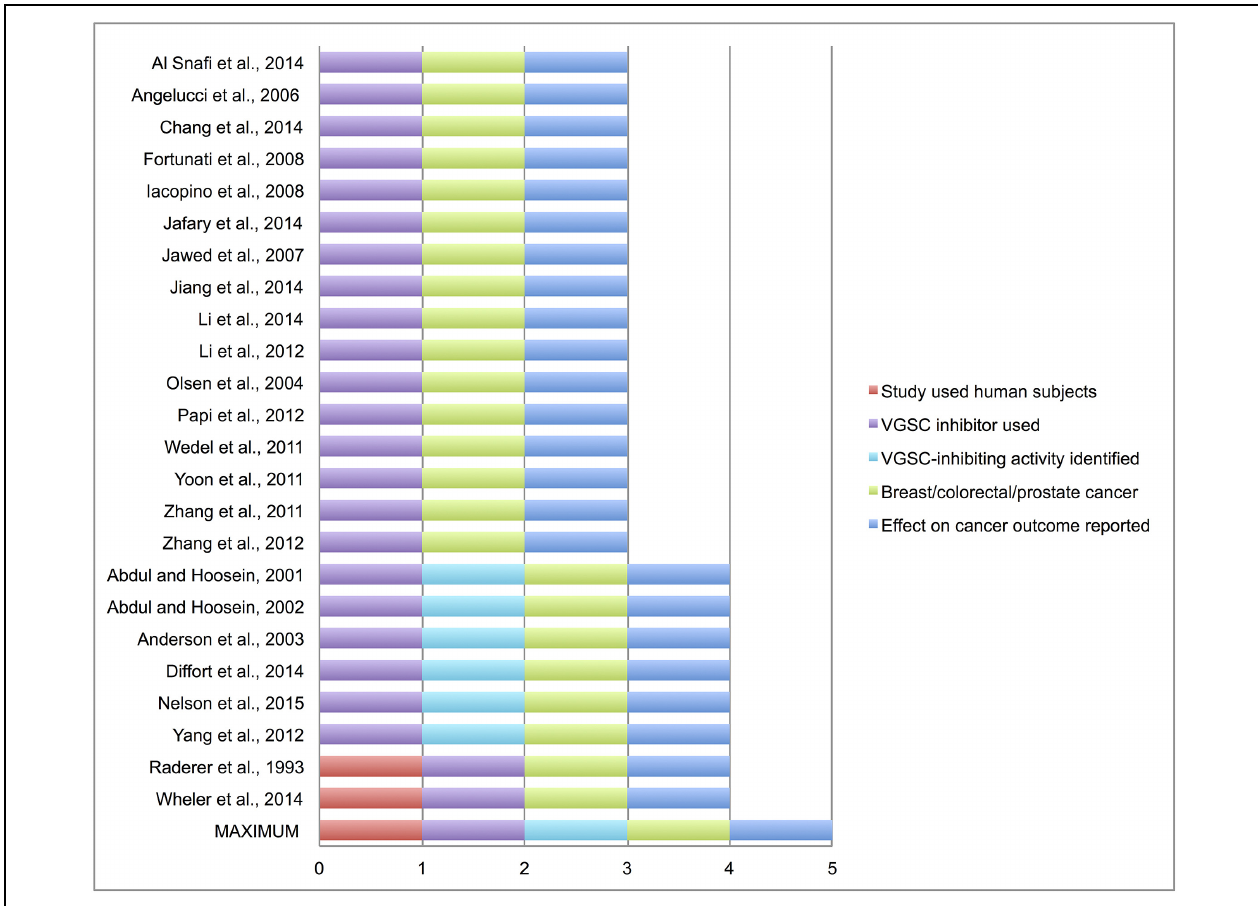
FIGURE 2 | Scoring of included studies. Study quality and evidence was quantified in the included studies (2 clinical and 22 preclinical) according to the modified standardized pre-piloted criteria assessment tool in Supplementary Table S3. Maximum score = 5, minimum score for inclusion in systematic review =